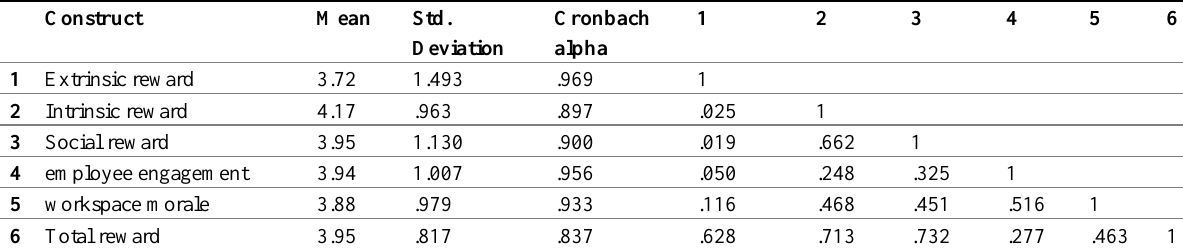
Table 1: Means, standard deviations, rank, Cronbach’s alphas and correlations